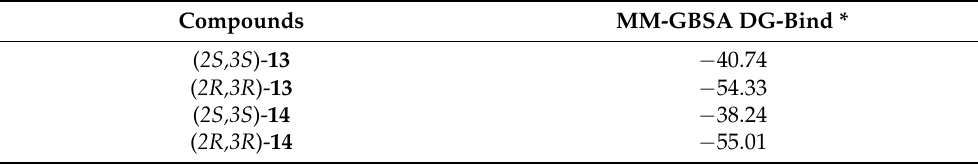
Table 2. MM-GBSA DG-Bind values of the studied